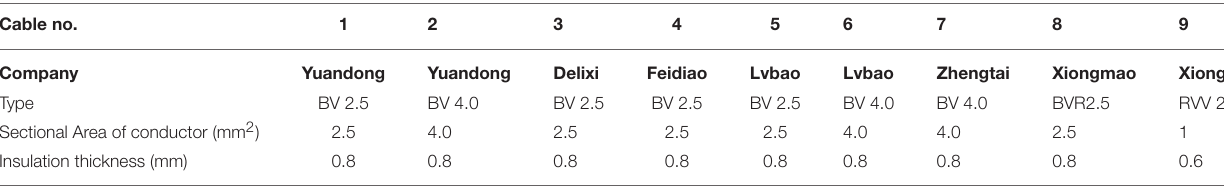
TABLE 1 | Specification of the cables used in this study. Cable